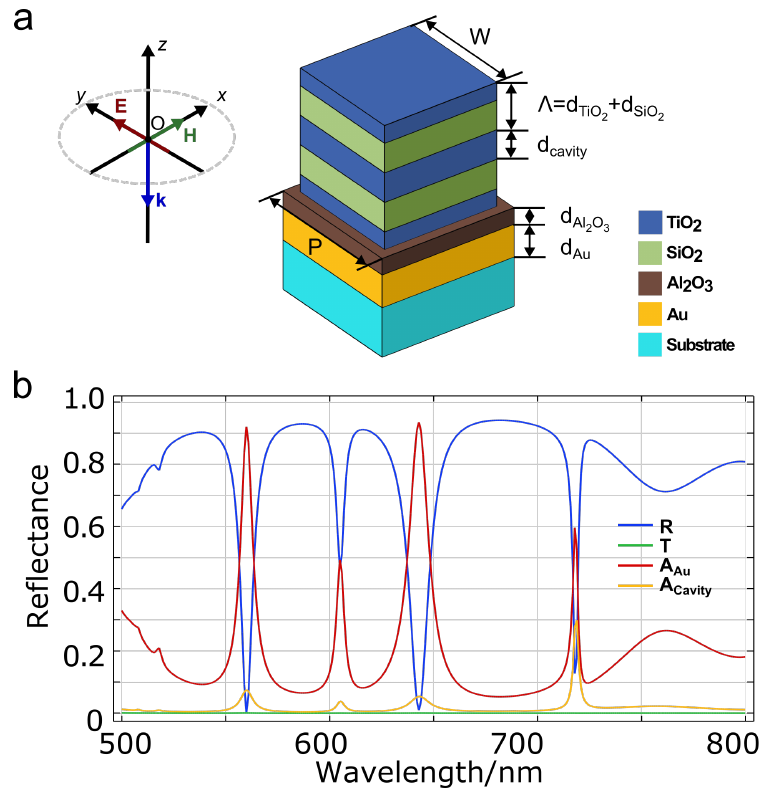
Figure 1. ( a ) Schematic representation of the metamaterial unit cell and a TE wave illumination in Cartesian coordinate. ( b ) Reflectance ( R ), transmittance ( T ), and absorption ( A ) spectra of the metamaterial under normal TE illumination. A = A Au + A cavity , where A Au and A cavity are evaluated in Au layer and cavity array,